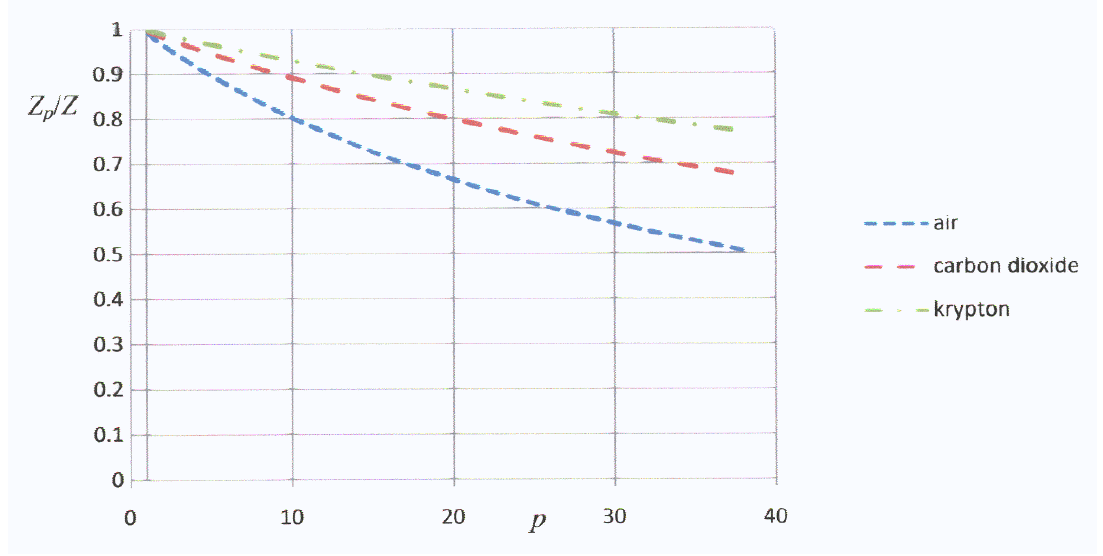
Figure 3. Plots of relative value for the thermoelectric figure of merit against the porosity factor for pores filled with air, carbon dioxide and